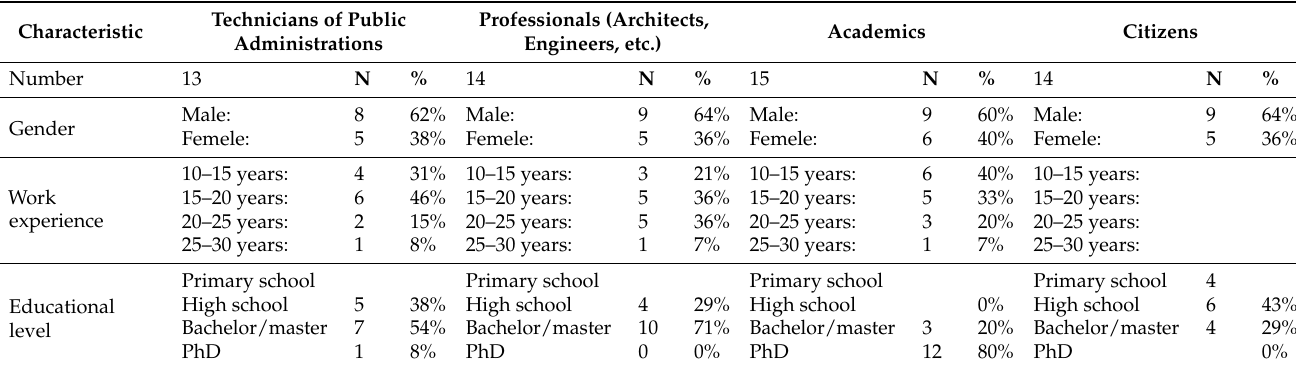
Table 2. Composition of the Panel and main